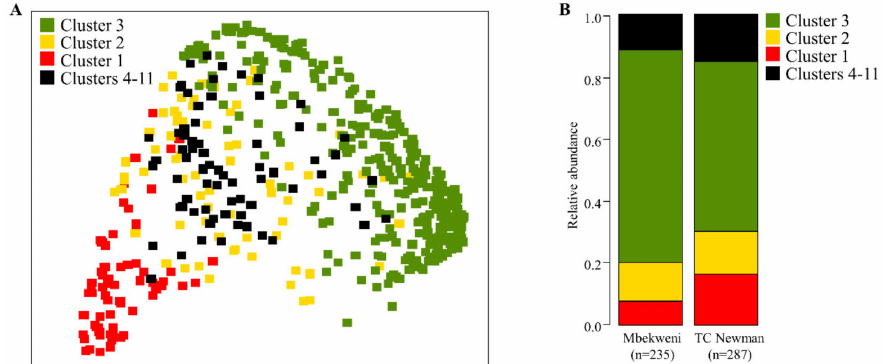
Figure 3. Human breast milk (HBM) bacteriome profiles colored by clusters. ( A ) Principal coordinate analysis (PCoA) of Bray–Curtis distance matrices of bacteria genera from all 522 HBM samples in the study. ( B ) Bar plots showing the proportion of di ff erent clusters detected from each study